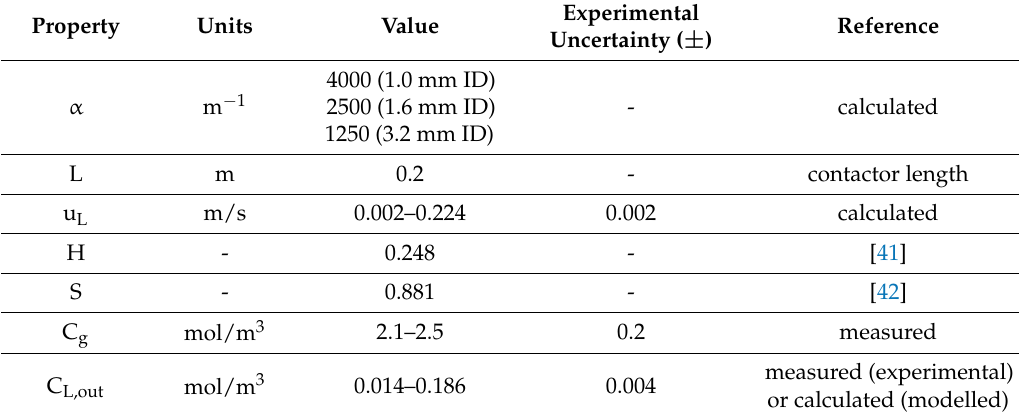
Table 3. Parameters used for calculation of K L and N. ID: inner